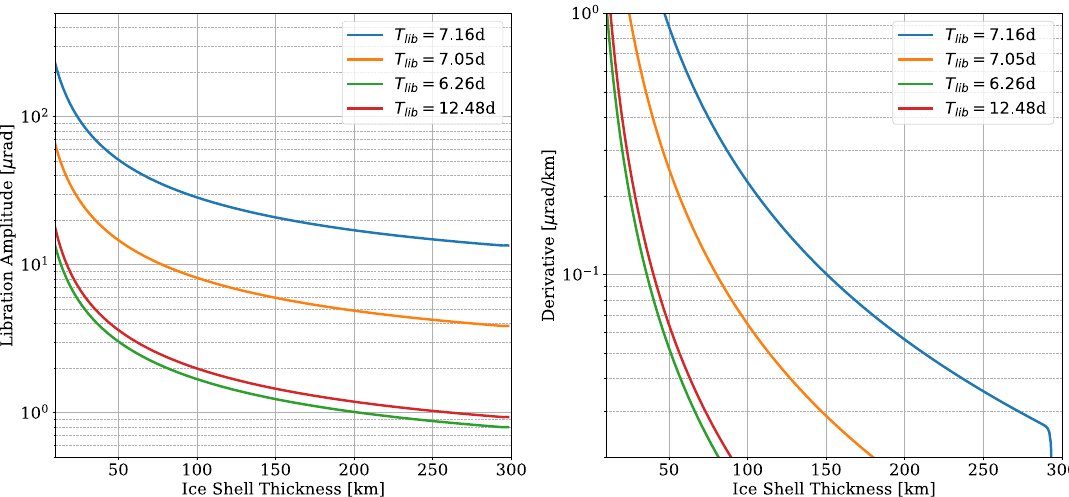
Figure 5. ( Left ): Libration amplitudes as a function of ice thickness for an elastic shell for different forcing periods T lib . ( Right ): Derivative of the libration amplitude as a measure for the sensitivity of the individual forcing frequencies to the ice shell thickness.